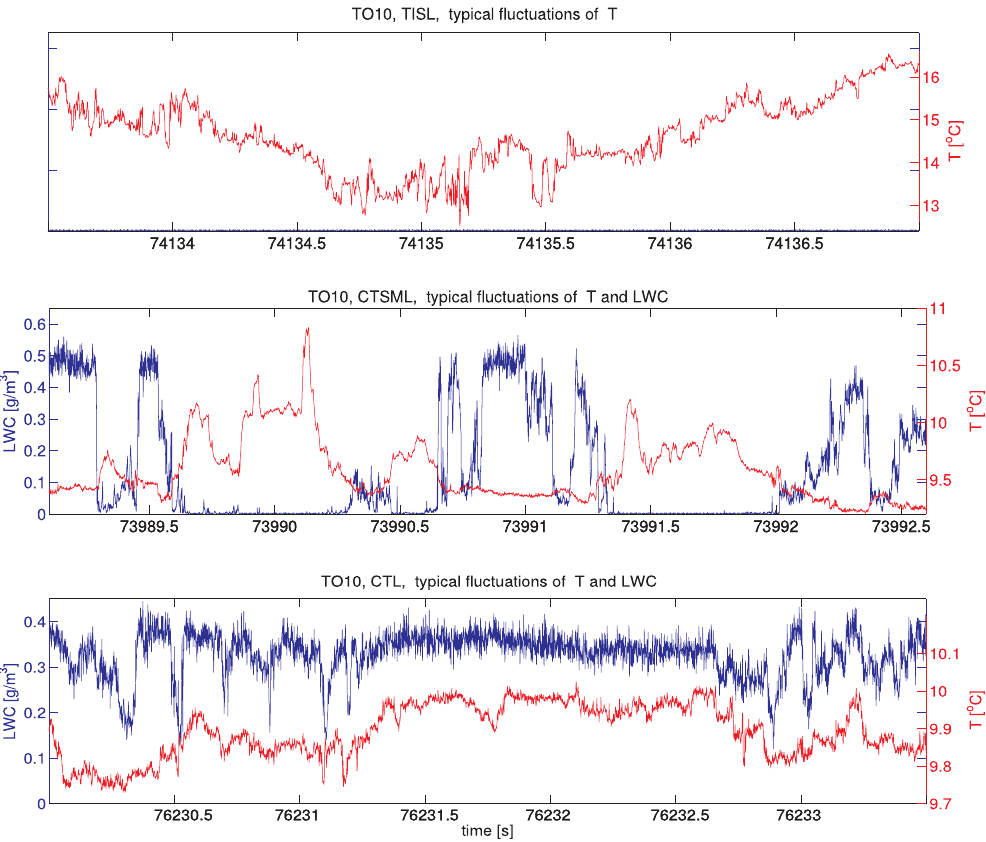
Fig. 6. Typical high resolution ( ∼ 5 . 5 cm ) records of temperature and LWC fluctuations in TISL (upper panel), CTMSL (middle panel) and CTL (bottom panel) from flight TO10.